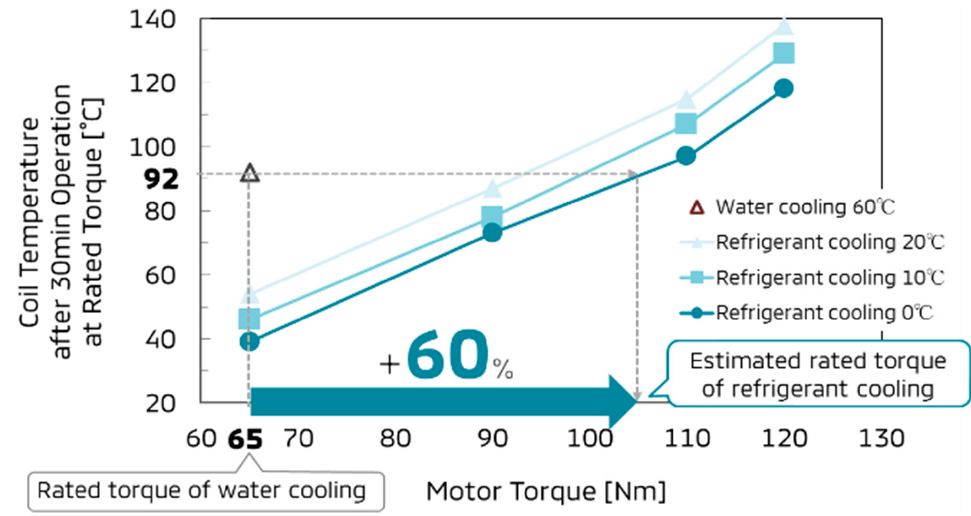
Figure 8. Coil temperature after 30 min operation vs motor torque.